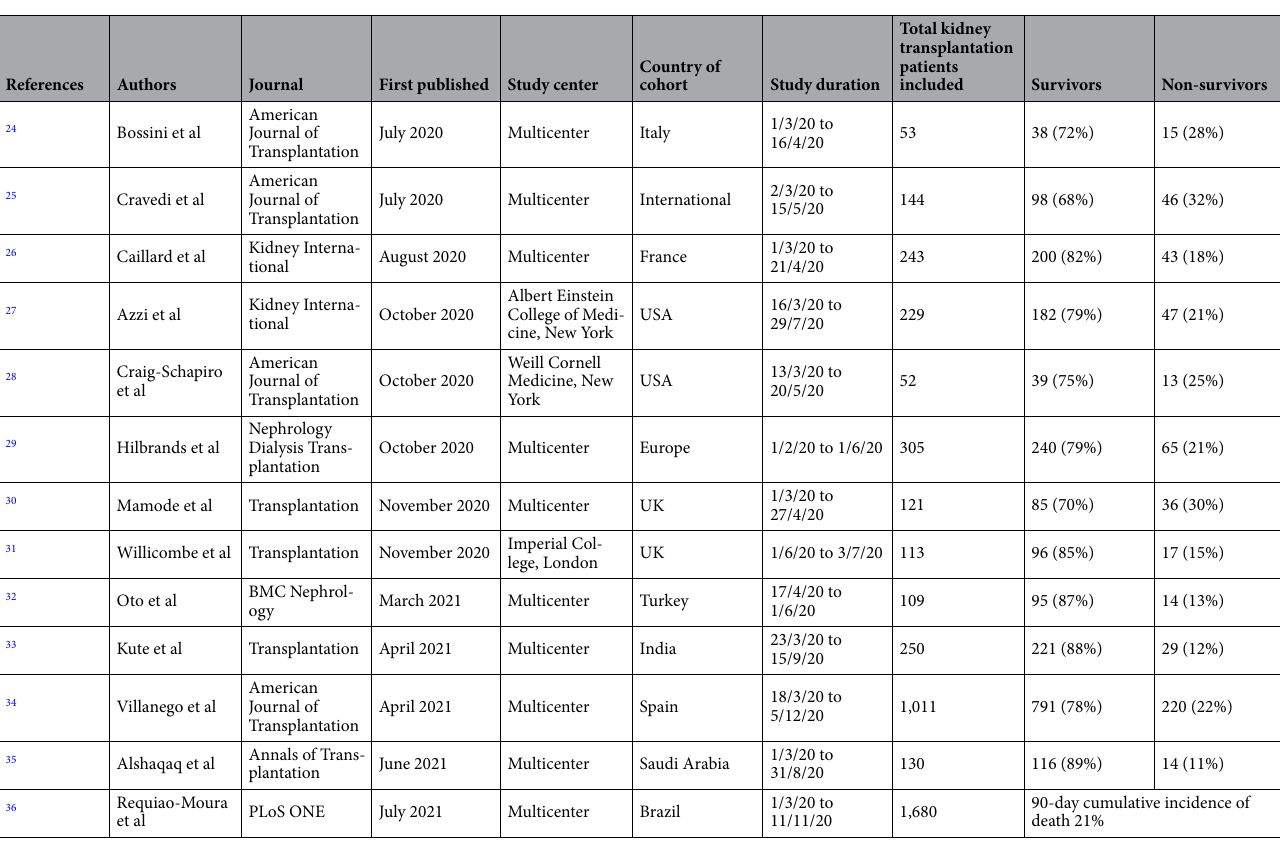
Table 1. Summary characteristics of included